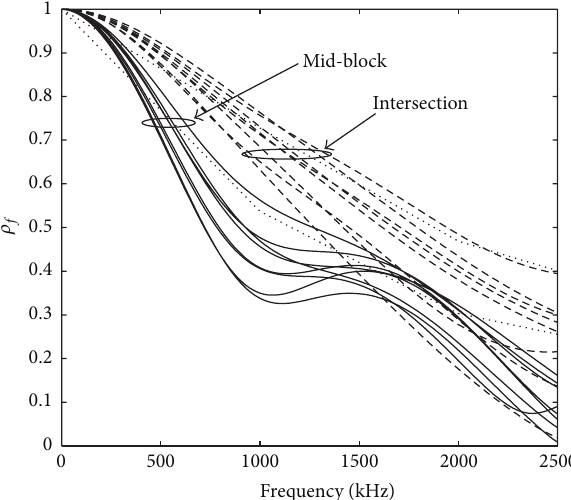
Figure 5: Spatially averaged frequency correlation function at 2GHz for the mid-block region (solid lines) and the intersection (dashed lines). The model correlation functions for 𝜏 0 = 0.25 𝜇 s and = 0.15 𝜇 s are also shown (dotted lines). 𝜏 0